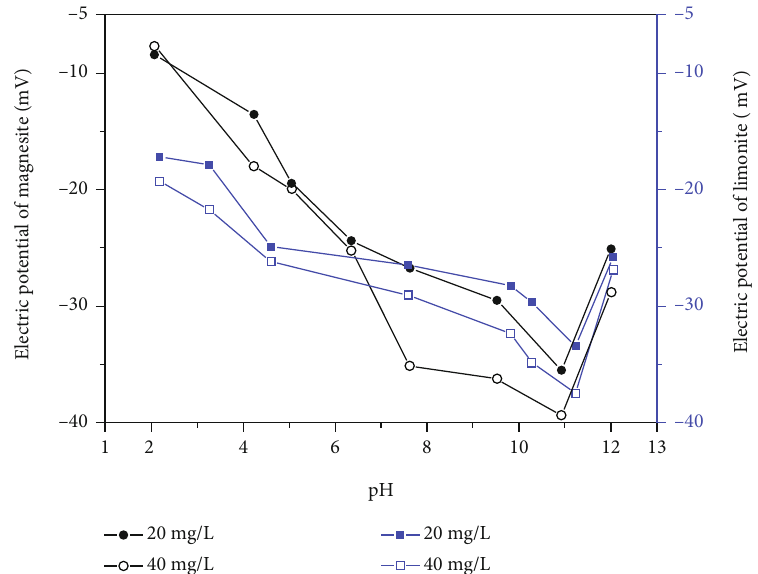
Figure 8: E ff ect of sodium hexametaphosphate on the zeta potential of magnesite and limonite.